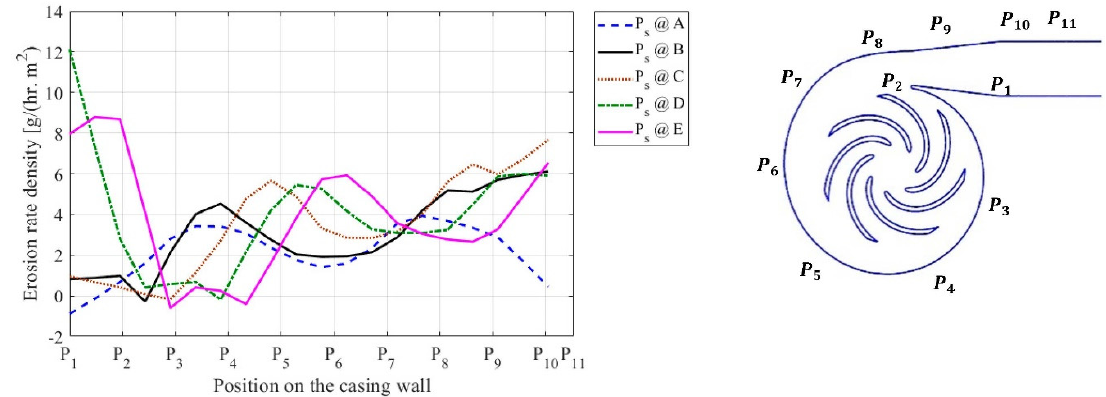
Figure 15. Variation of erosion rate density along the casing wall with different solid particle sizes and distribution.